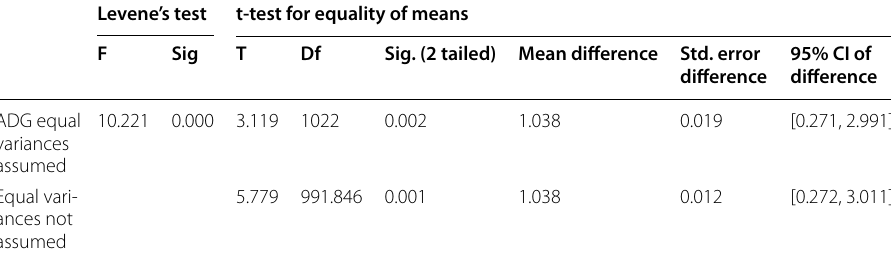
Table 4 Independent sample t-test (ADG) Levene’s test